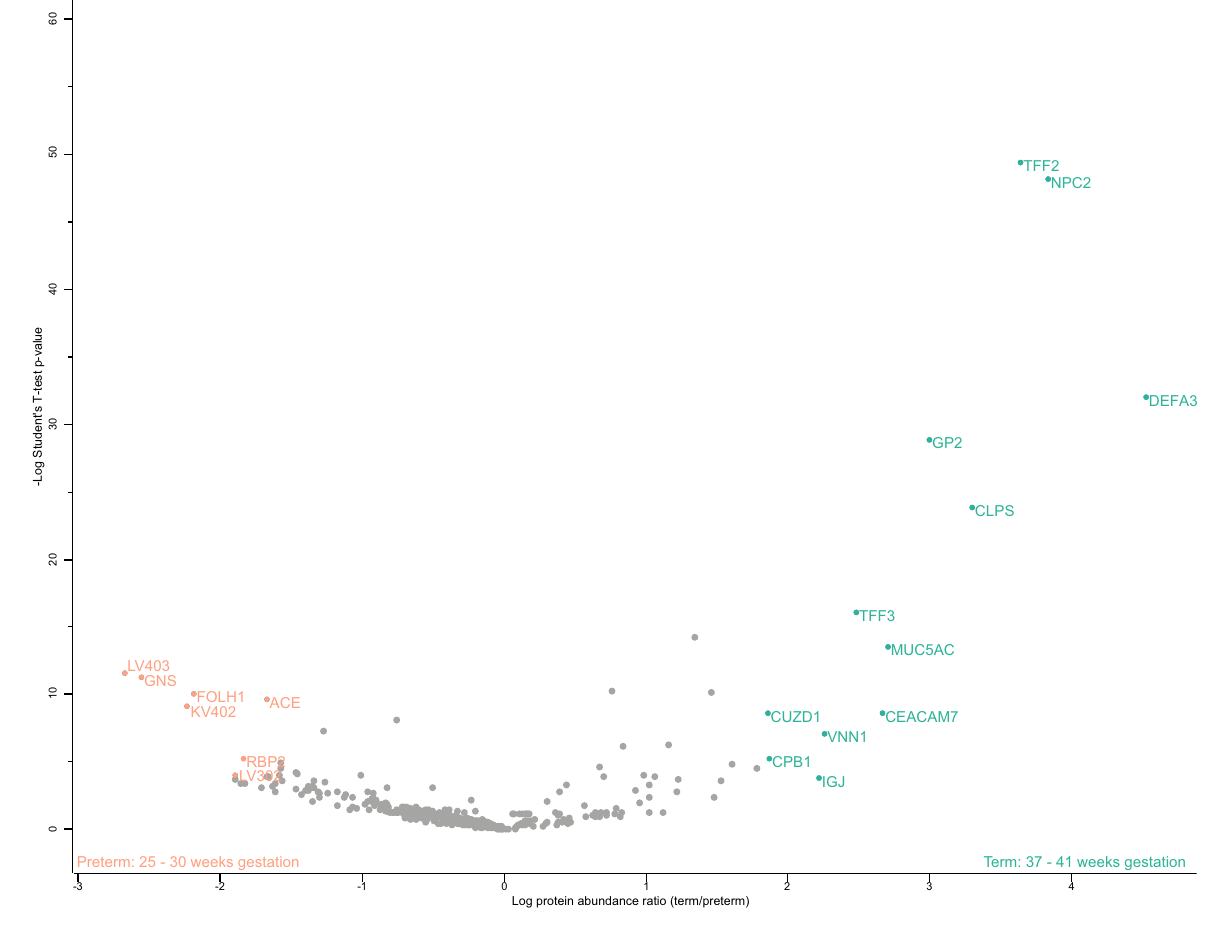
Figure 5. Volcano plot showing differences within the fecal proteome of preterm and term infants. LFQ intensities of fecal samples from preterm (n = 64) and term (n = 17) infants were used to generate the volcano plot in Perseus version 1.6.2.1 56 . LFQ intensities were 10log transformed, samples were assigned to its designated study group and compared with a Student’s two-sample t-test with permutation-based FDR correction. P-values as indicated on the y-axis are -10log transformed. The differentially expressed proteins are marked by gene names. Upregulated proteins in preterm infants include: LV403: Ig lambda chain V-IV region Hil; GNS: Glucosamine (N-acetyl)-6-sulfatase; FOLH1: Glutamate carboxypeptidase 2; ACE: